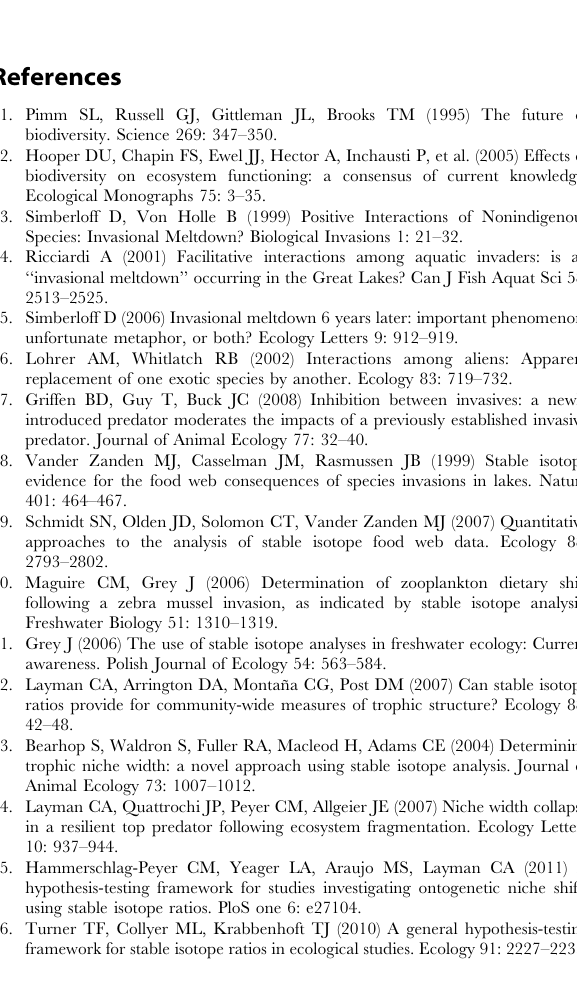
Figure 6. Arrow-diagrams showing the change in mean crayfish isotopic composition before and after carp dominance. Lines show the change before (solid lines) and after (dashed lines) carp dominance. Each arrow displays the mean isotopic change of crayfish carbon and nitrogen values compared to the previous sampling period. The length of each arrow represents the magnitude of change and the direction illustrates the angle of change.